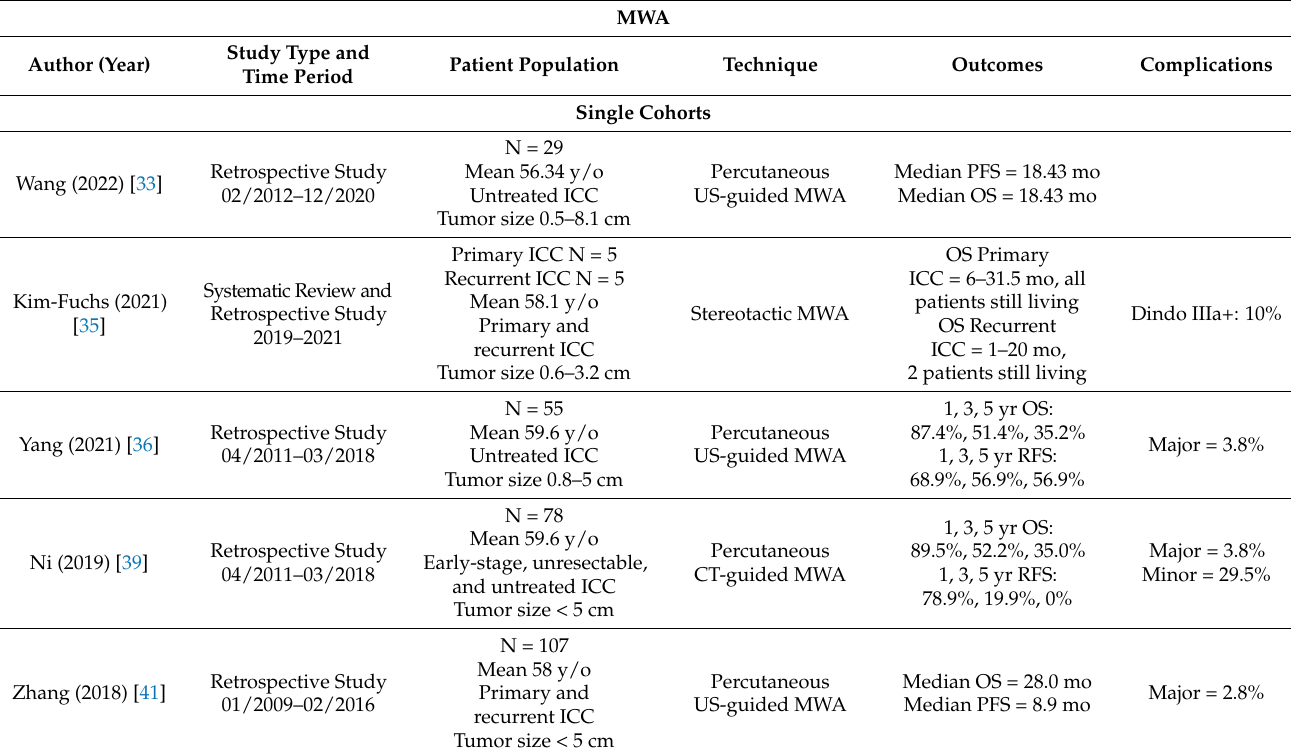
Table 2. Studies examining microwave ablation (MWA) for intrahepatic cholangiocarcinoma.